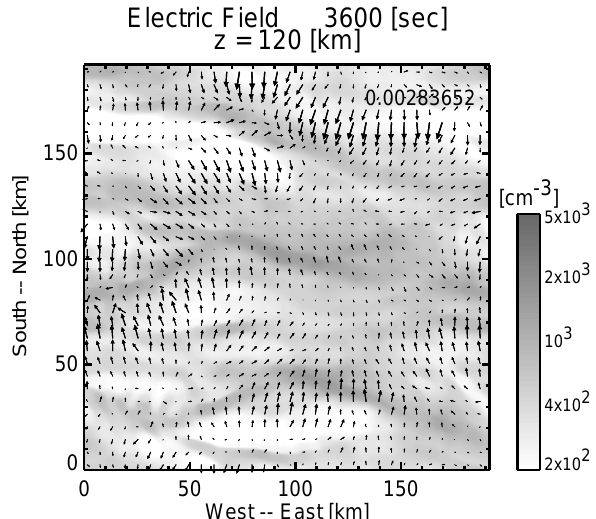
Fig. 5. Plasma density distribution (background) and the polar- ization electric field (arrows) on the horizontal plane at 120km at 3600s, after applying the gravity waves propagated from the lower atmosphere. (Reproduced from Yokoyama et al. (2004b).)